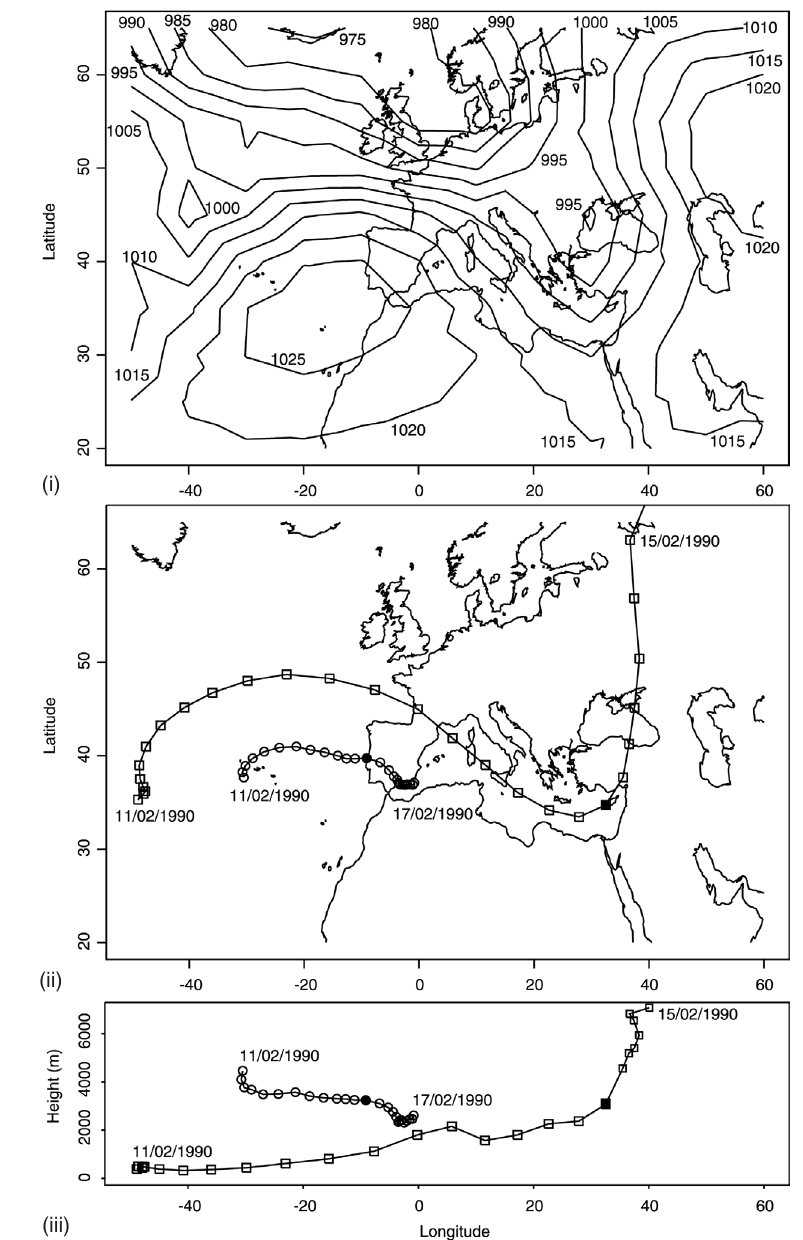
Fig. 6b. i) The pressure map for the 13th February 1990. ii) The forward and back trajectories for the 700 mb level at Lisbon (crosses) and Paphos (open circles). The markers are placed at 6 hourly intervals. iii) The trajec- tory heights for Lisbon (crosses) and Paphos (open circles). Solid symbols 00:00 on